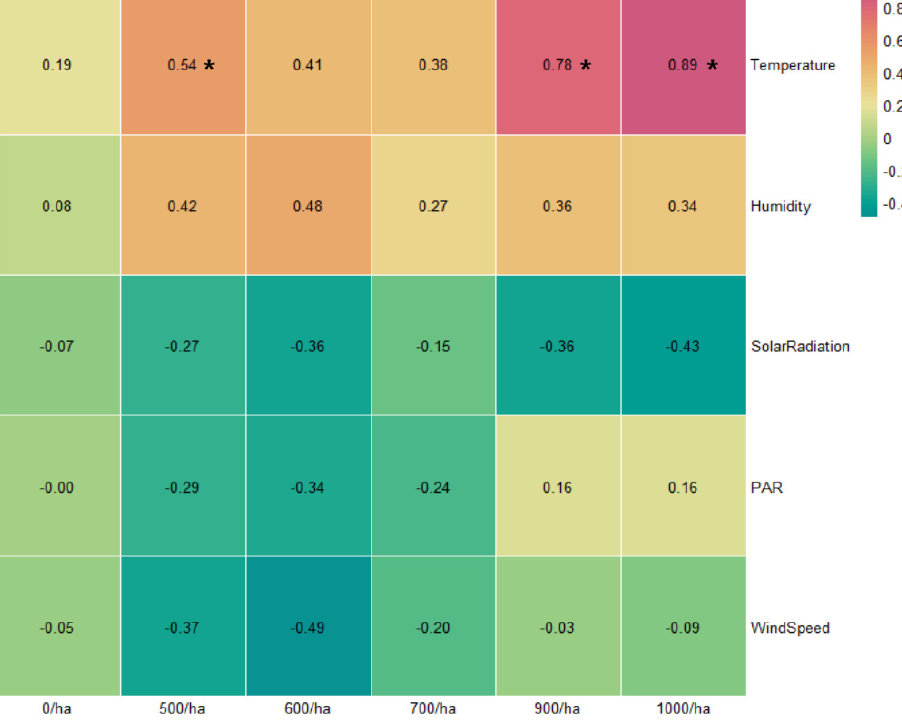
Figure 7. Pearson correlation coefficient results between microclimate factors and TNVOC emissions by forest density (* p < 0.05).